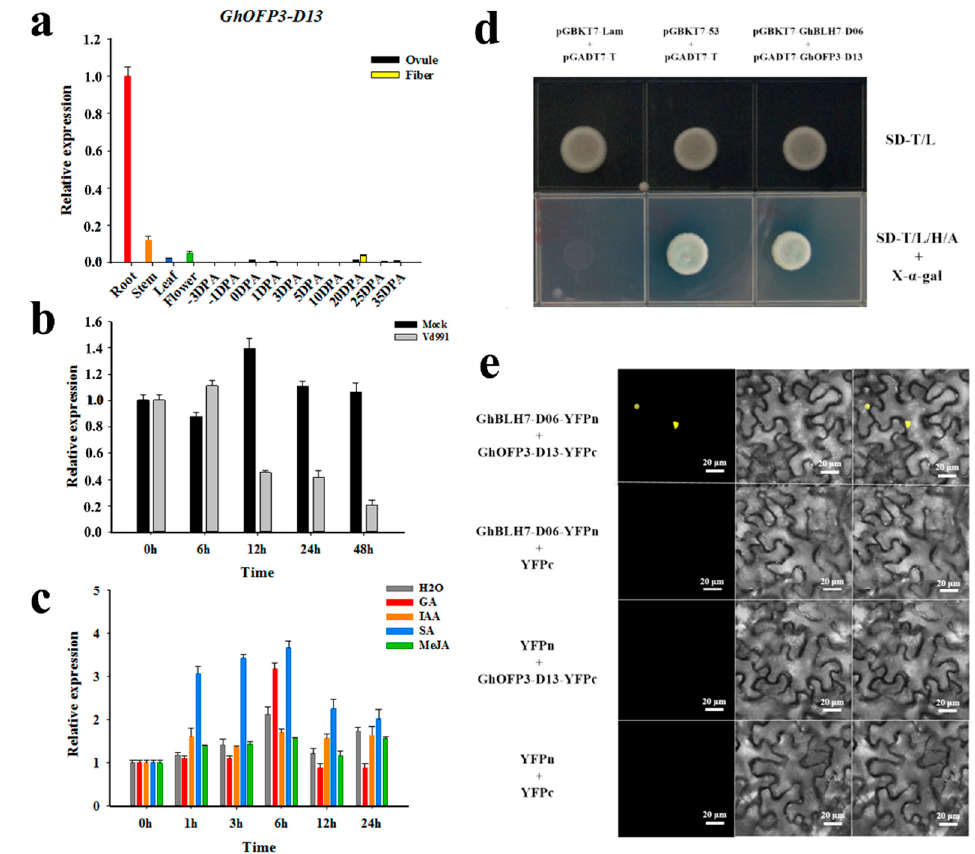
Figure 5. Validation of interaction between GhBLH7-D06 and GhOFP3-D13 and the expression patterns of GhOFP3-D13 in cotton: ( a ) the expression level of GhOFP3-D13 in di ff erent tissues in TM-1; ( b ) the expression pattern of GhOFP3-D13 in response to V. dahliae ( Vd991 ) treatment; ( c ) the expression patterns of GhOFP3-D13 responds to phytohormones (GA, IAA, SA and MeJA); ( d ) negative control group (pGADT7-T + pGBKT7-lam), positive control group (pGADT7-T + pGBKT7-53), and experimental group (pGADT7-GhOFP3-D13 + pGBKT7-GhBLH7-D06) grown on two-deficiency medium SD-T / L (SD-Trp / -Leu) and four-deficiency medium SD-T / L / H / A + X- α -gal (SD-Trp / -Leu / -His / -Ade + X- α -gal); and ( e ) BiFC assays for determination of GhBLH7-D06 and GhOFP3-D13 interactions in Nicotiana benthamiana leaf cells (scale bar = 20 µ m). Error bars represent the standard deviation of three biological replicates. Asterisks indicate statistically significant di ff erences, as determined by Student’s t -test (* p < 0.05; ** p < 0.01).